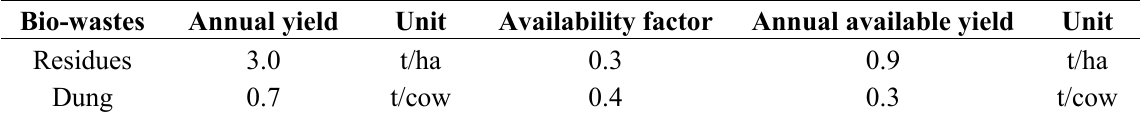
Table 3. Summary of annual average production of bio-wastes and its available